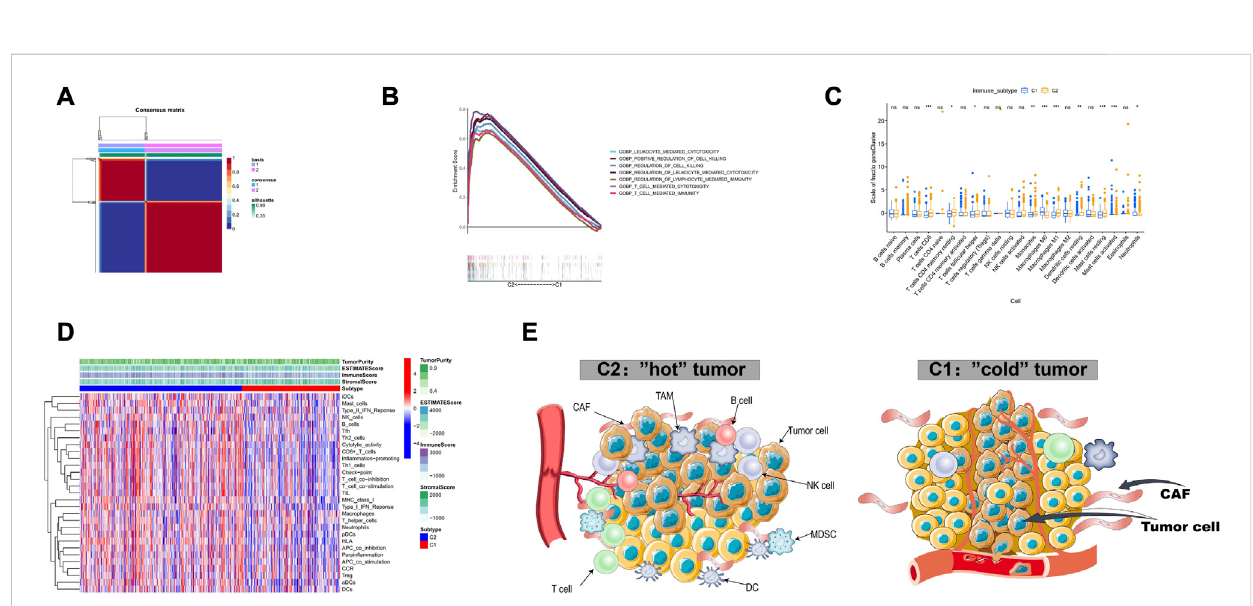
FIGURE 2 Identi fi cation of two immune subtypes based on TCGA-LUAD (A) Identi fi cation of two immune subtypes, C1 and C2, based on 510 samples with NMF optimal k = 2. (B) GSEA analysis showed that C2 had higher immune activity compared to C1. (C) Relative abundance of immune cells in both immune subtypes. (D) Heatmap of the 29 immunogenomes of the two immune subtypes, with higher cytotoxicity, immune checkpoint and pro- in fl ammatory process activity in C2 compared to C1. (E) Tumor microenvironment pro fi les of the two immune subtypes.